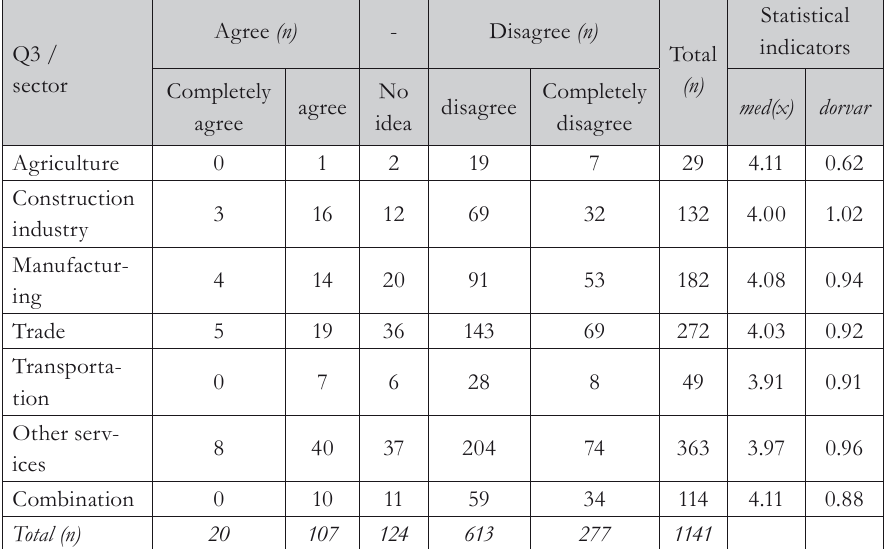
Tab. 9 – Pivot table for Q3a absolute frequency and Statistical characteristics. Source: